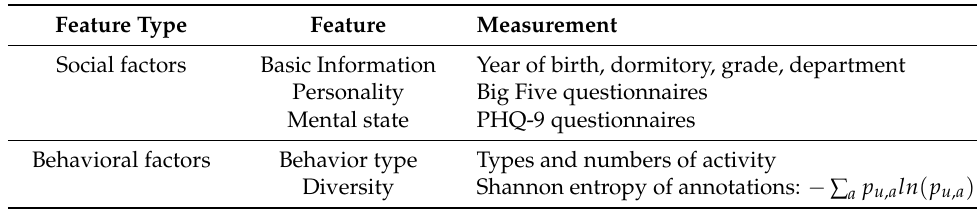
Table 1. List of features for clustering individuals. In the Measurement column, p u , a indicates the probability of activity a